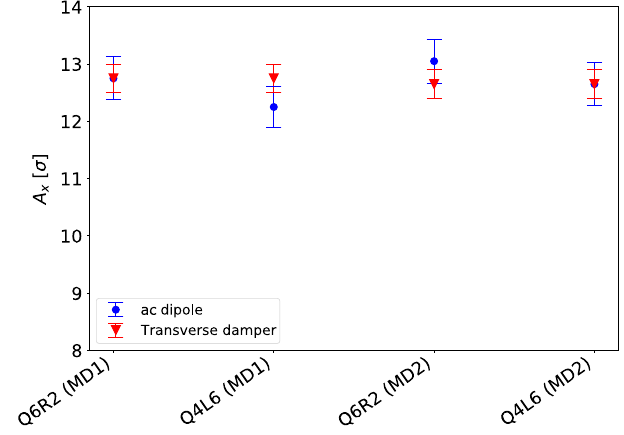
FIG. 10. Summary of the horizontal aperture measurements performed for beam 1 at injection energy and optics with the ac dipole (blue) and the transverse damper (red) methods during MD1 and MD2.